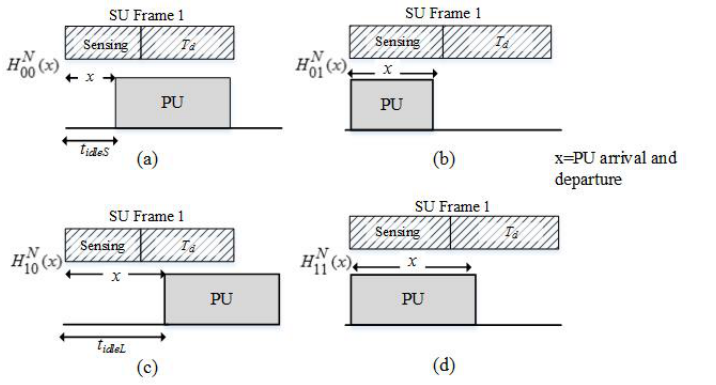
Figure 6. The PU’s traffic model of the CTOL